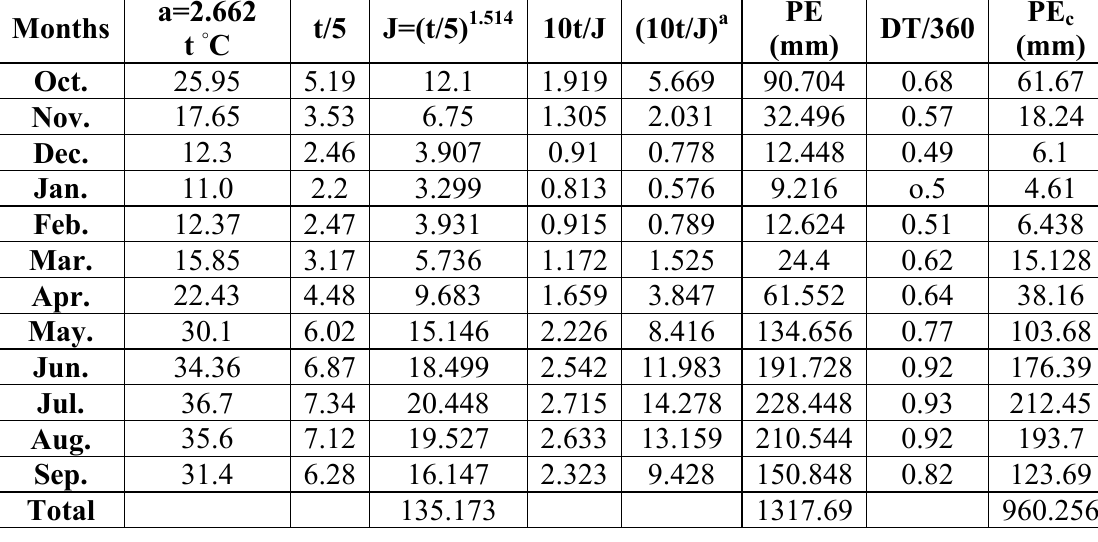
Table 3: Potential evapotranspiration (PE) mm for Mandali Basin by